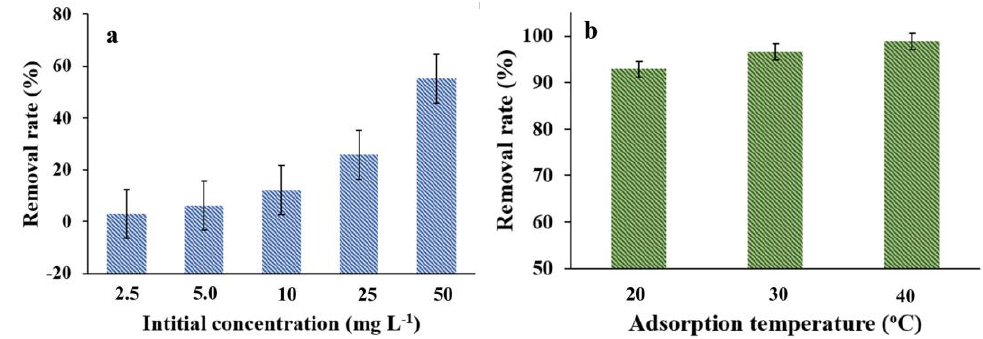
Figure 9. ( a ) The change of adsorption capacity vs initial concentration; and ( b ) the change of adsorption rates vs. temperature. All the curves were obtained in NOR solution with a dosage of 0.8 g L − 1 at a pH of 7.0.